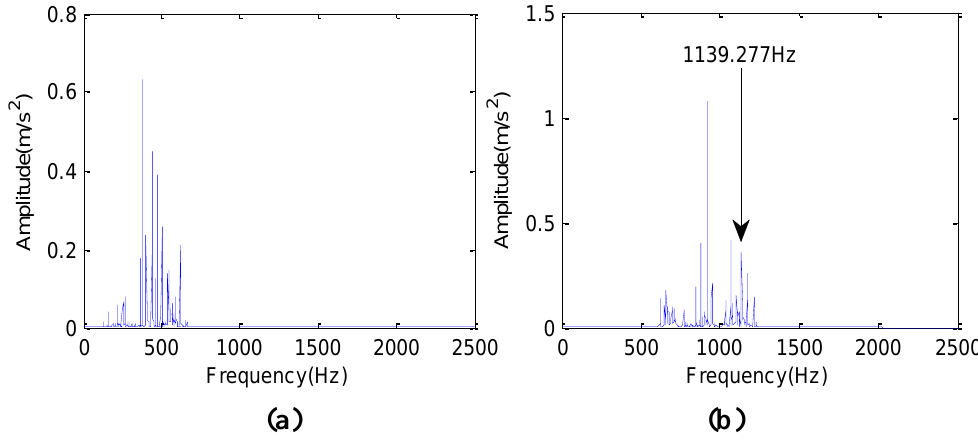
Figure 9 . The time domain signals obtained at 1:00 on September 1st, 2006 through wavelet lifting analysis. (a) the spectrum range of c 1 is 0~625 Hz; (b) the spectrum range of d 1 is 625~1,250 Hz; (c) the spectrum range of c 2 is 1,250~1,875 Hz; (d) the spectrum range of d 2 is 1,875~2,500